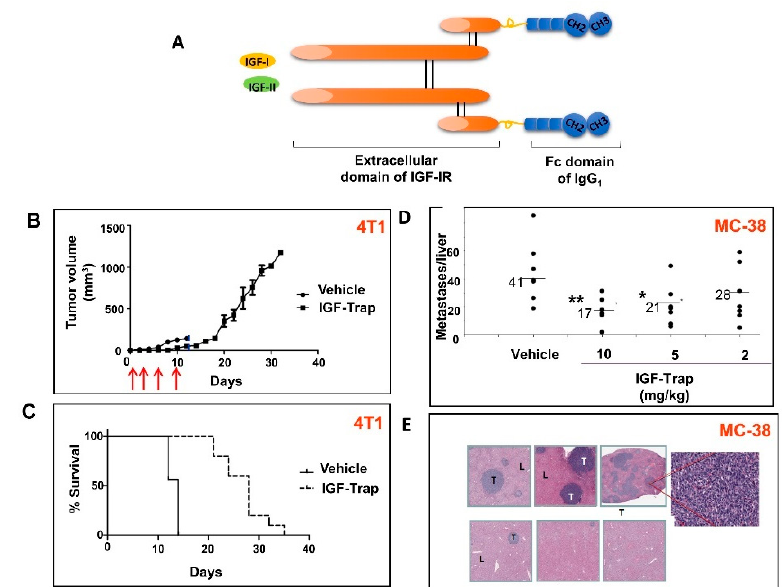
Figure 3. The IGF-Trap inhibits the orthotopic growth of mammary carcinoma and liver metastasis of colon carcinoma cells. Balb / c ( B and C ) or C57Bl / 6 ( D and E ) mice were injected into the mammary fat pad (MFP) with 5 × 10 4 4T1 cells ( B and C ) or via the intrasplenic / portal route with 5 × 10 4 MC-38 cells ( D and E ). IGF-Trap injections were administered i.v. to 4T1 injected mice 4 h and 3, 6 and 10 days (arrows) post tumor inoculation (10 mg / kg for the first 2 injections and 5 mg / kg subsequently) and to MC-38 injected mice, 24 h and 4 and 7 days post tumor inoculation. Shown in ( A ) is a diagrammatic representation of the 2 nd generation IGF-Trap. Shown in ( B ) are mean tumor volumes ( ± SD) and in ( C ) a Kaplan–Meier survival curve ( p < 0.01 using Mantel-Cox or Gehan-Breslow-Wilcoxon Tests). Local MFP tumors grew rapidly in all untreated mice, causing morbidity by day 14, while in the treated mice, tumor growth was seen only after cessation of treatment. Shown in ( D ) are the numbers of visible liver metastases enumerated 18 days post tumor injection. Bars (and numbers) denote medians. Shown in ( E ) are representative hematoxylin and eosin-stained, formalin-fixed and para ffi n-embedded sections obtained from di ff erent livers of MC-38-injected mice (magnification × 20; inset × 400). T: tumor; L: liver; * p < 0.05; ** p < 0.01. Reproduced from